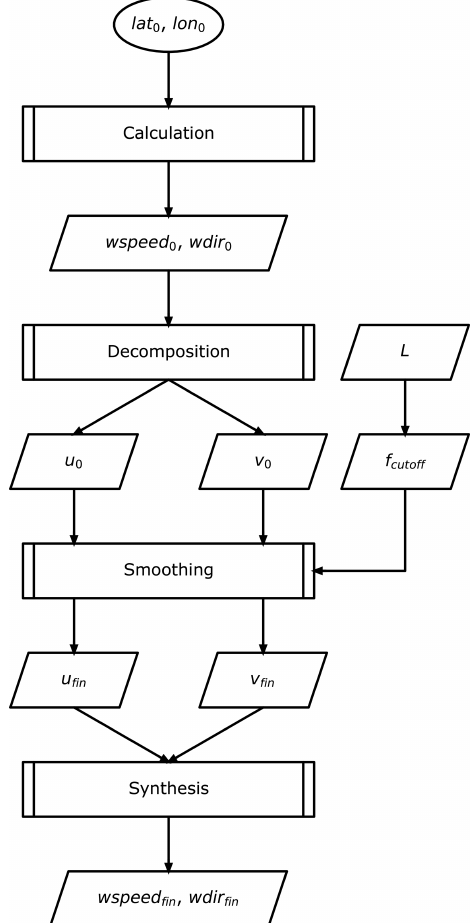
Figure 8. As per Fig. 3 but for